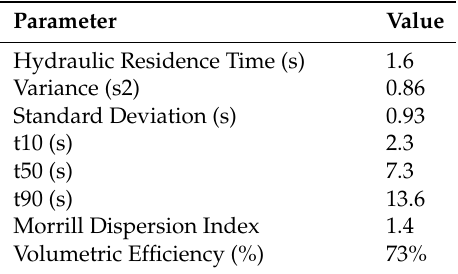
Figure 6. Measured concentration of methyl green tracer at the outlet from the reactor used to determine the hydraulic residence time. Table 2. Hydraulic tracer test results.